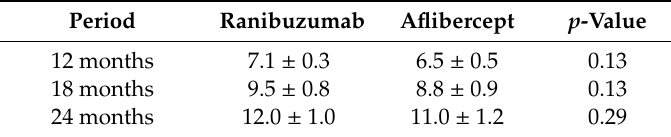
Figure 4. Number of intravitreal injections of ranibizumab (IVR) and aflibercept (IVA). Number of injections for each observation period is shown. The bar graph shows the number of injections at 12 months ( a ), 18 months ( b ), and 24 months ( c ). Data are shown as the percentage of all patients. Table 3. Injection numbers during maintenance